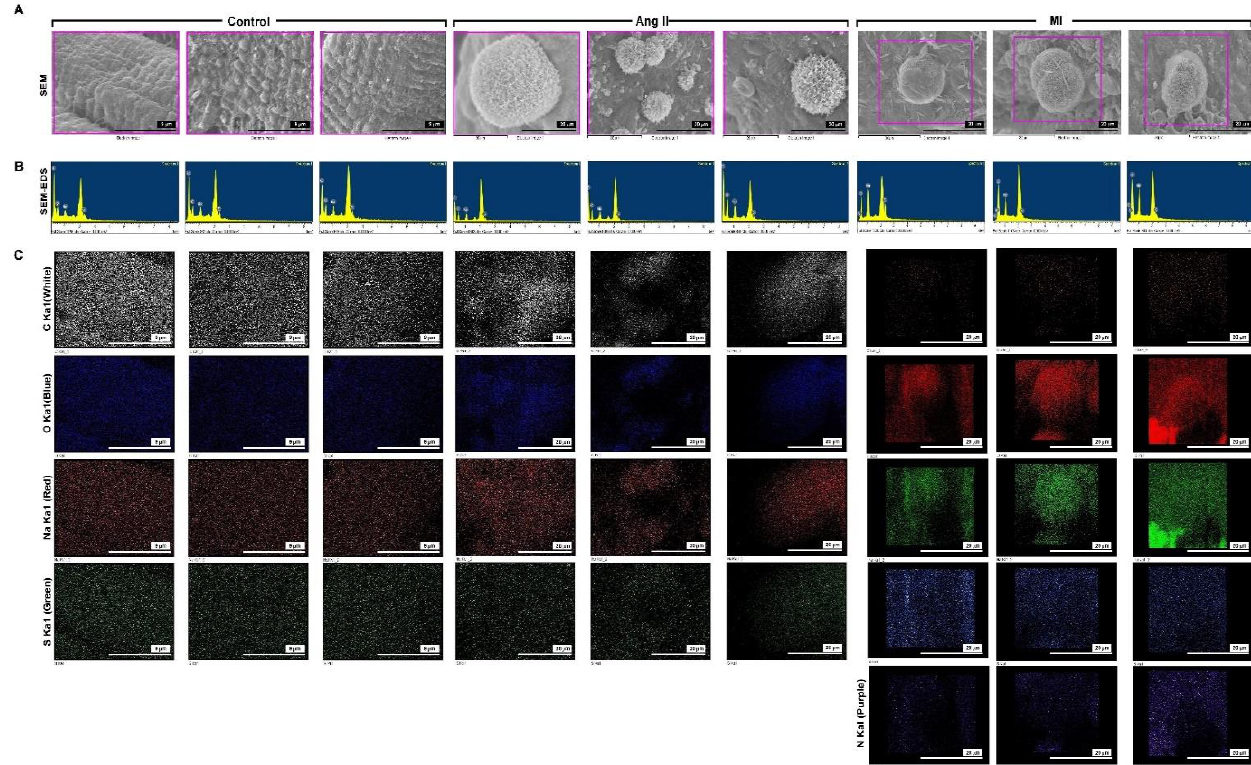
Figure 4. SEM/energy dispersive x-ray spectrometry (SEM/EDS) elemental mapping of the mineral deposition in the Ang II- and ischemia heart-induced HF models. ( A ) SEM images of HF animal model. ( B ) SEM-EDS mapping. ( C ) Secondary electron image and analogous elemental mapping of carbon (C), oxygen (O), sodium (Na), sulfur (S), and nitrogen (N). Table 1. Quantification of area spectrum for the weight and atomic percentage of various elements